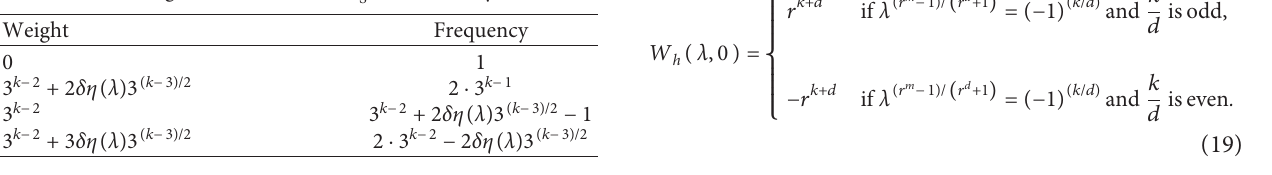
for Corollary 1 (ii). S